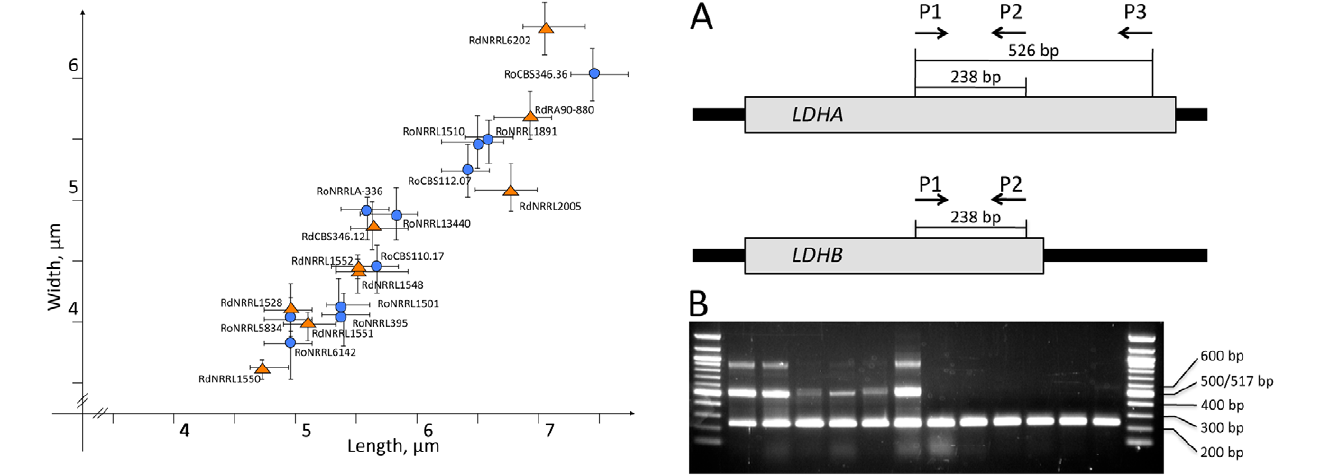
Figure 4. Range of sporangiospore sizes for isolates from the Rhizopusoryzae complex. Naming convention includes the species prefix (Ro – Rhizopus oryzae , Rd – Rhizopus delemar ) followed by the strain number. Bars indicate the 95% confidence interval.